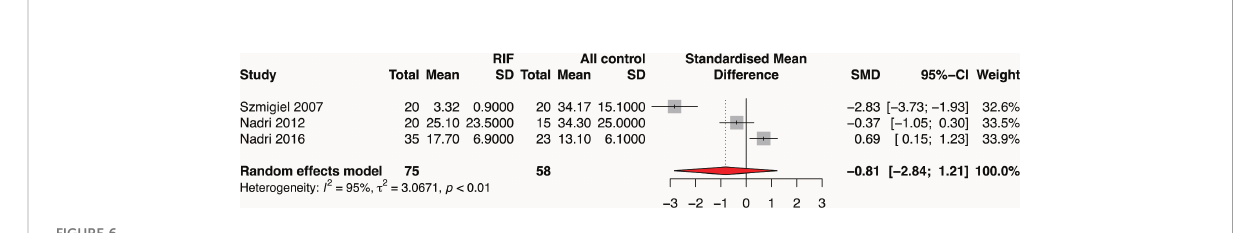
FIGURE 6 Forest plot showing the association of circulating sHLA-G concentration with